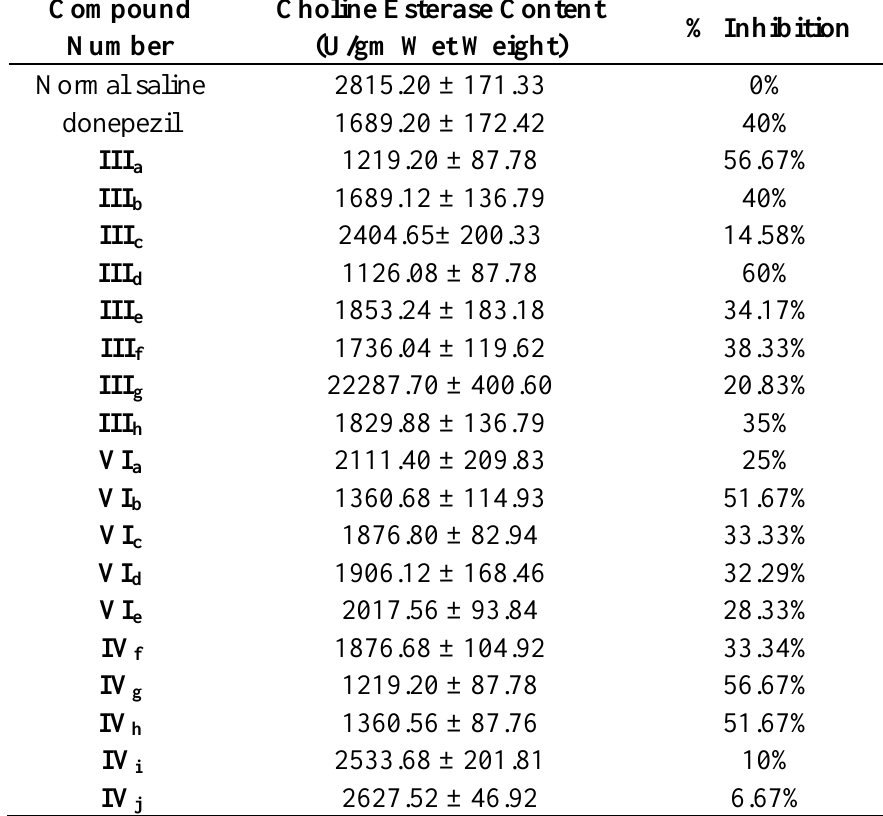
Table 1. Inhibition of AChE activity of donepezil and the synthesized anticholinesterase